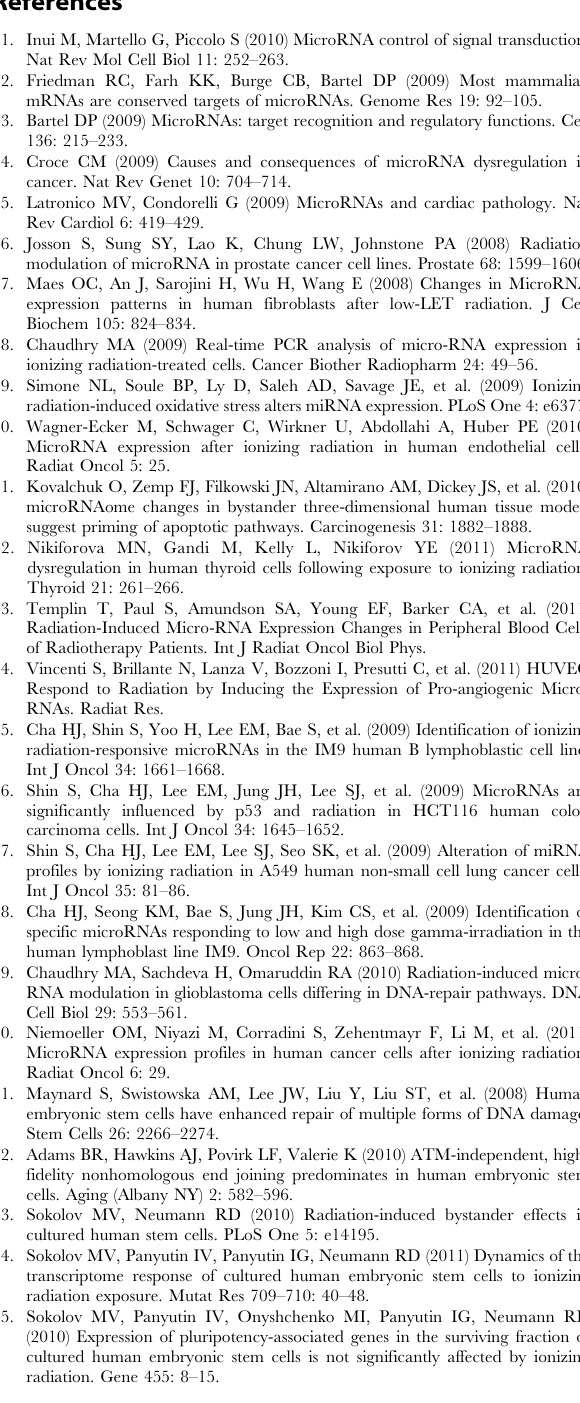
Table S5 Down-regulated ( . 1.5 - fold) miRNA genes (1 Gy, 16 hr) in H1 (p , 0.05). (DOC) Table S6 Up-regulated ( . 1.5 - fold) miRNA genes (1 Gy, 2 hr) in H9 (p , 0.05). Table S7 List of up-regulated ( . 1.5 - fold) miRNA genes (1 Gy, 16 hr) in H9 (p ,